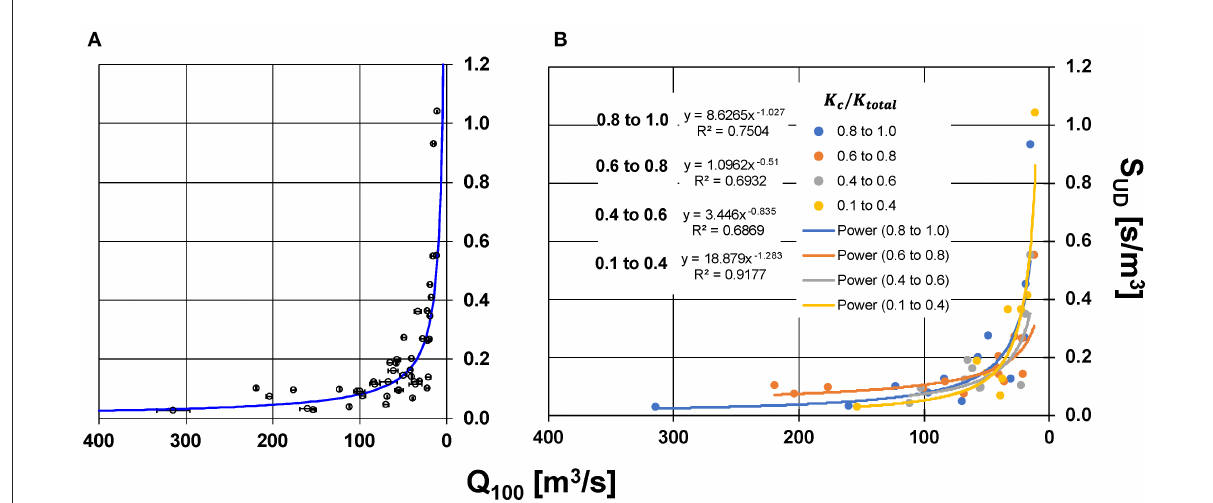
FIGURE5 Relationships between Q 100 (100-year 24-h reach-averaged peak discharge) and aggregate relative flood sensitivity measure S UD . (A) Plot of the overall inverse relationship between Q 100 and S UD for the study channels where horizontal bars denote the standard errors of Q 100 . (B) Plot of the inverse relationships disaggregated into different classes based on the k